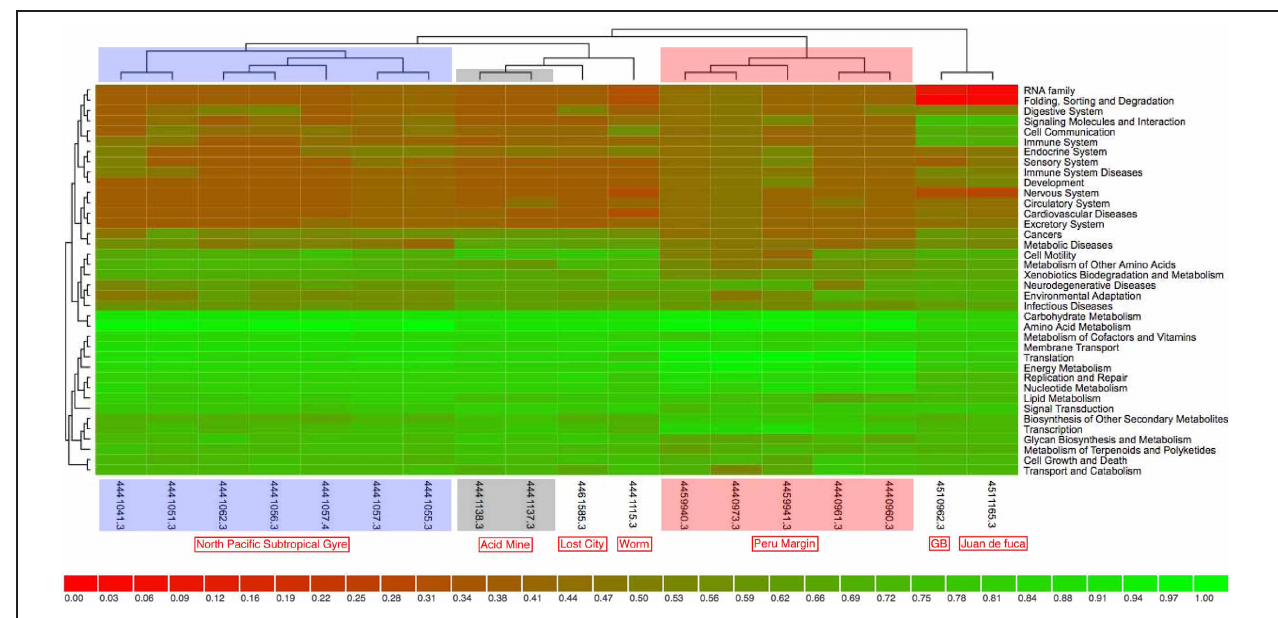
FIGURE 3 | The data was compared to KEGG database using a maximum e-value of 1e − 5 , a minimum identity of 30%. The heatmap was clustered using ward clustering with Canberra distance